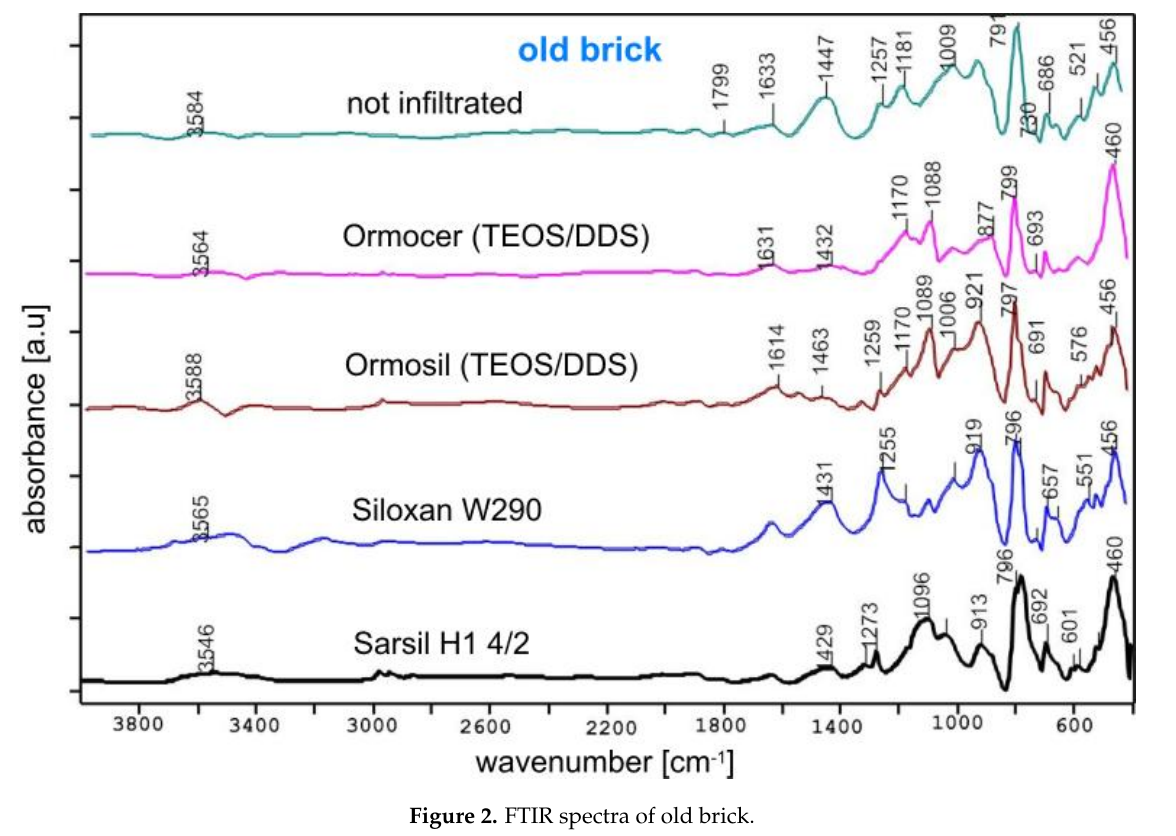
Figure 2. FTIR spectra of old brick.